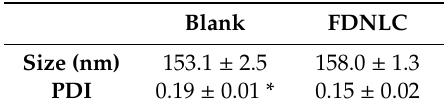
Table 1. Comparison of particle size and polydispersity index (PDI) between FDNLC and the blank. Each value represents the mean ± SD ( n =